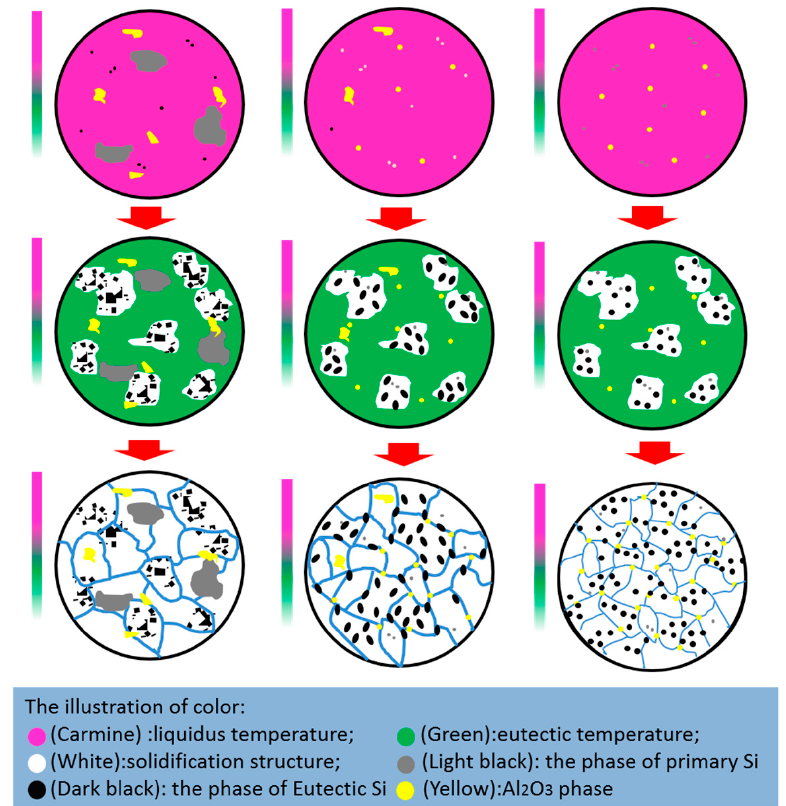
Figure 6. The microstructure formation mechanism of high pressure solidified Al 2 O 3 /Al-20Si com- posite.